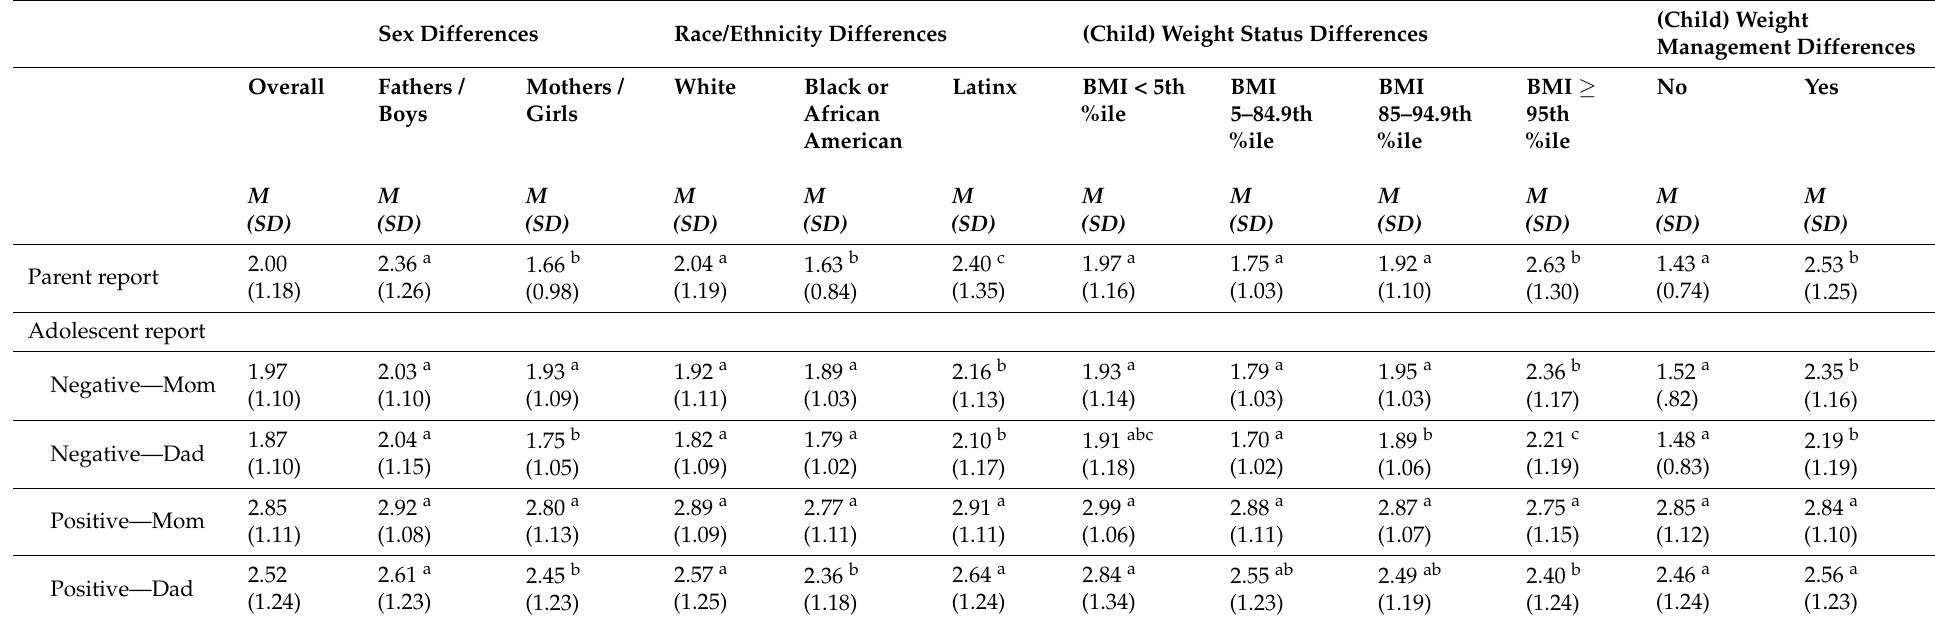
Table 5. Demographic and weight-related differences in frequency of parental weight